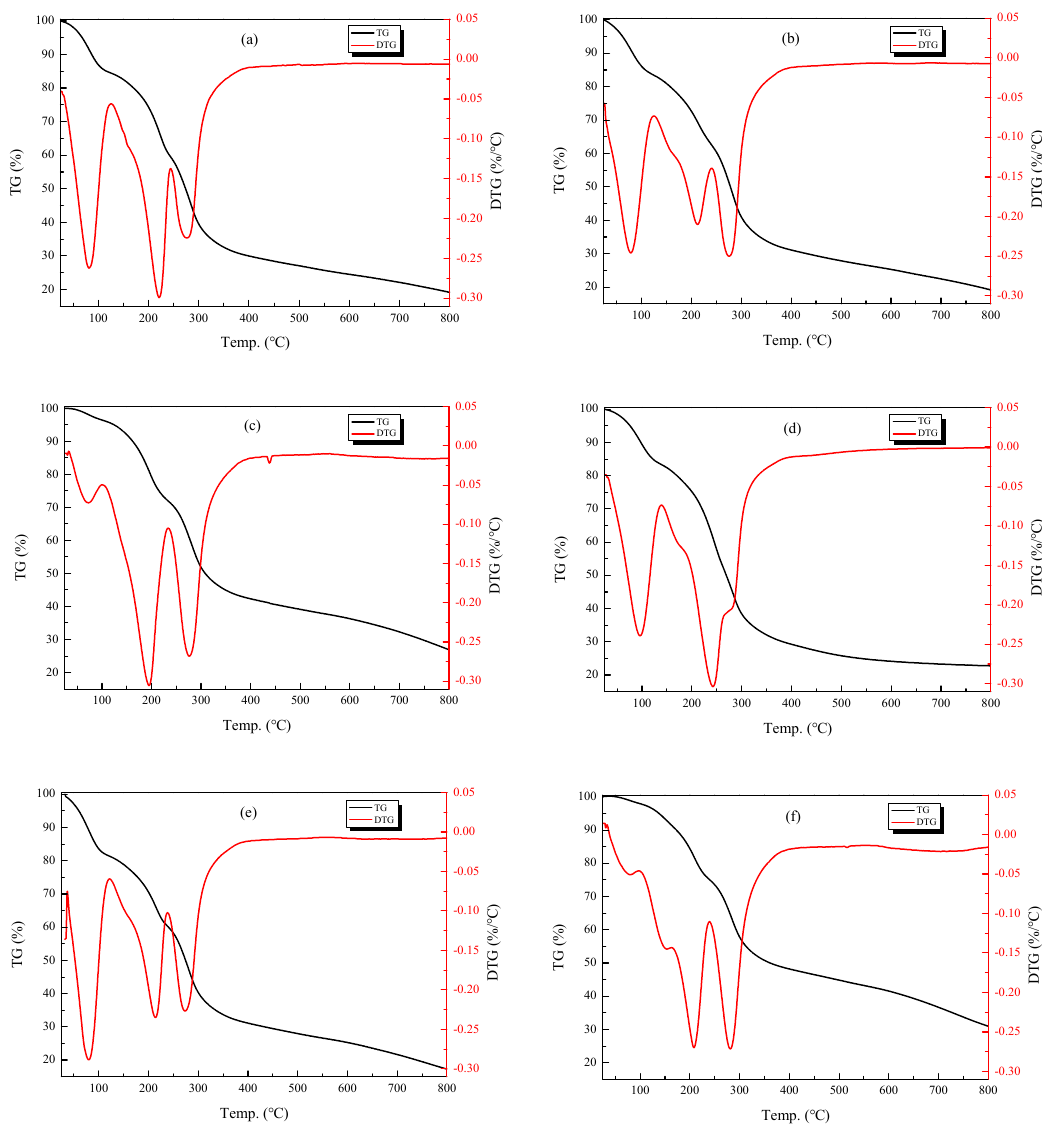
Figure 5. TG analysis of chitosan-based coating with different concentrations of TiO 2 nanoparticles ( a ) 0; ( b ) 0.01%; ( c ) 0.03%; ( d ) 0.05%; ( e ) 0.07%; ( f ) 0.09%).